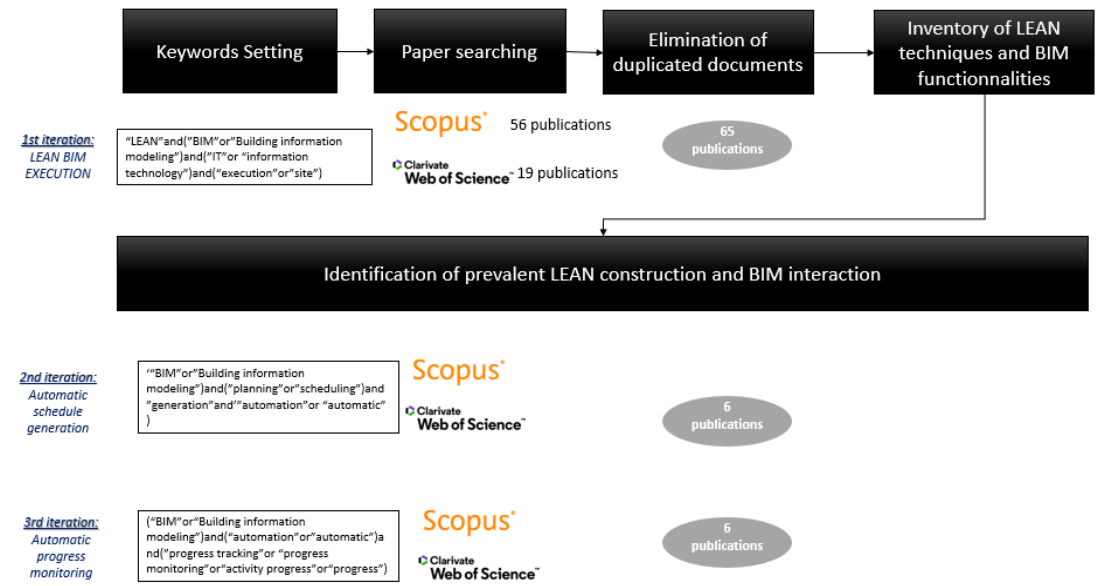
Figure 2. Research methodology.